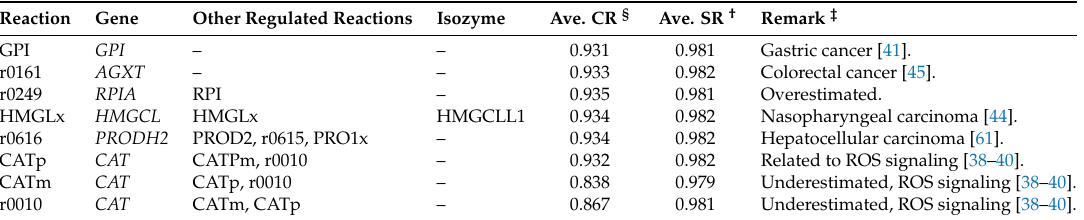
Table 2. Top six one-hit reactions. The criteria may overestimate or underestimate compared with the results solved by the pseudo-enzyme